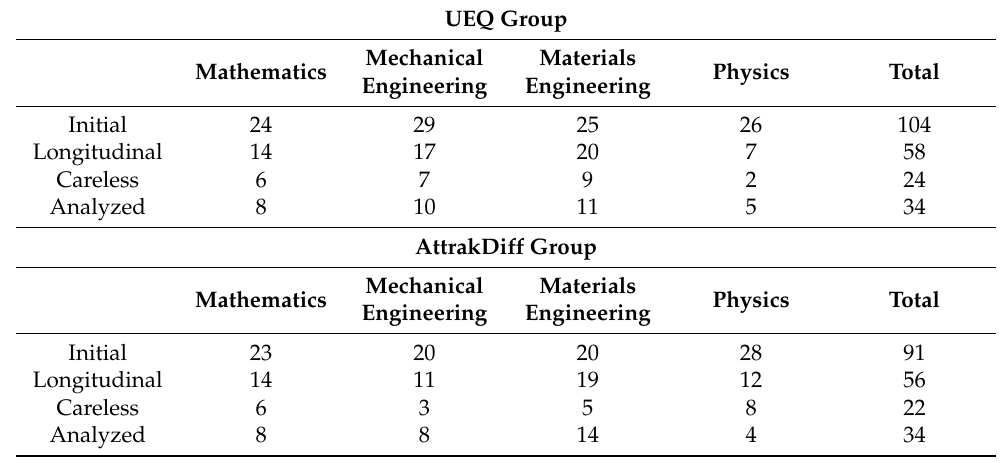
Figure 1. Frequency of longstrings per method. Table 2. Distribution of the participants along the study.